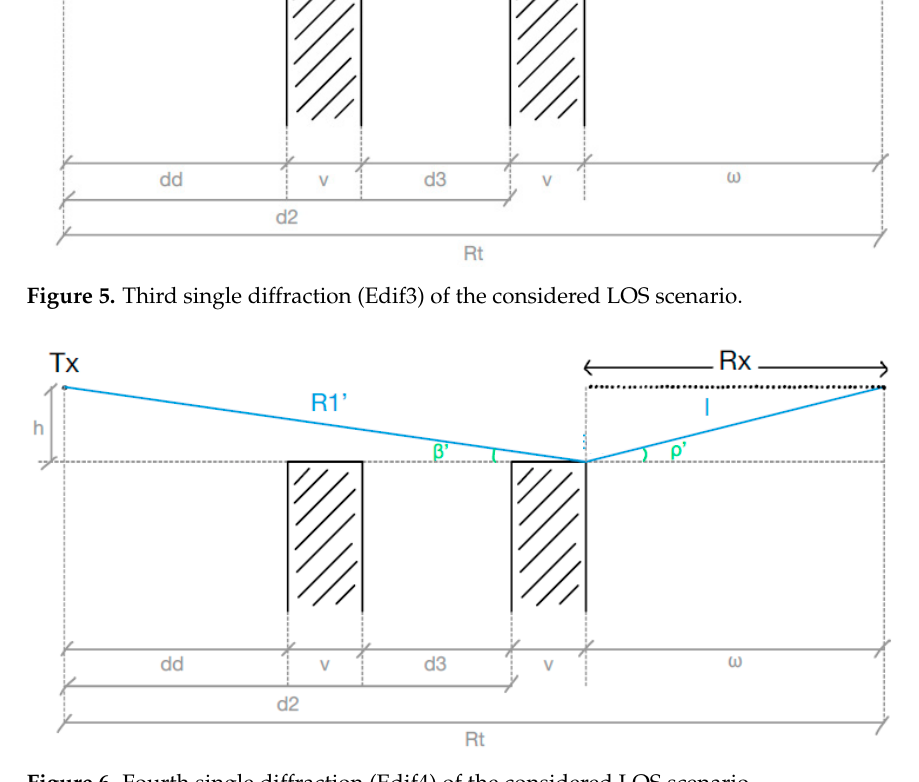
Figure 6. Fourth single diffraction (Edif4) of the considered LOS scenario.